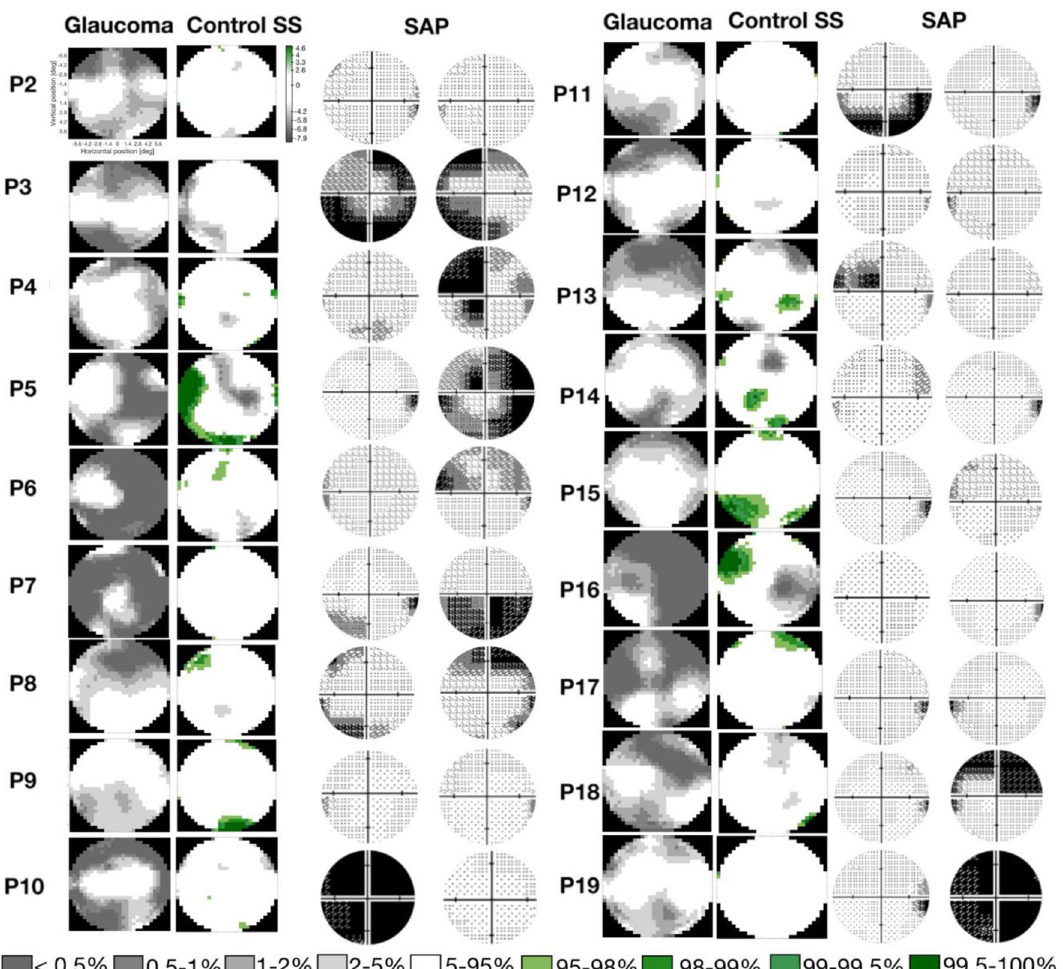
Figure 6. Comparison of the V1 visual field reconstruction between glaucoma and control SS participants. VF reconstruction glaucoma-control participants SS pairs and the SAP tests for the left and right eye are shown. Note that to compare the binocular reconstructed VF with the monocular HFA outcomes, the highest contrast sensitivity from both eyes should be considered. The visual field reconstructions were obtained using pRFs estimated using the micro-probing technique.